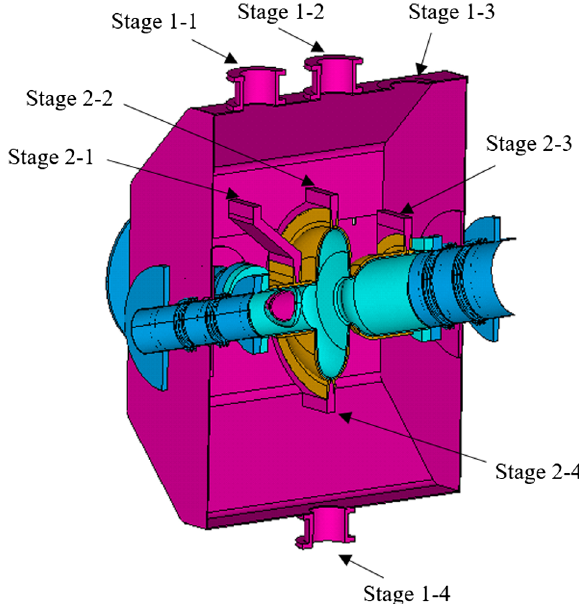
FIG. 2. 3D model used for the thermal analysis. Each color represents a different material: cyan indicates Nb, blue indicates stainless steel, orange represents electroplated Cu, and fuchsia represents Cu with RRR ¼ 100 . The nomenclature “ Stage 1-3 ” means stage 1 of cryocooler number 3.